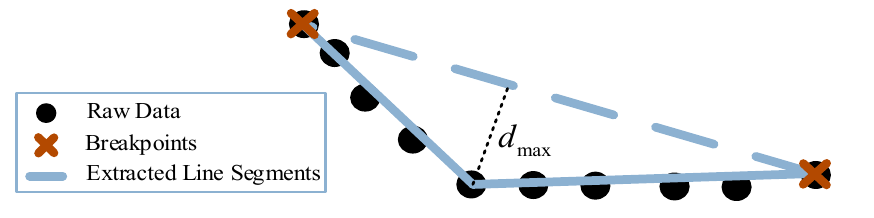
Figure 3. The IEPF algorithm principle.